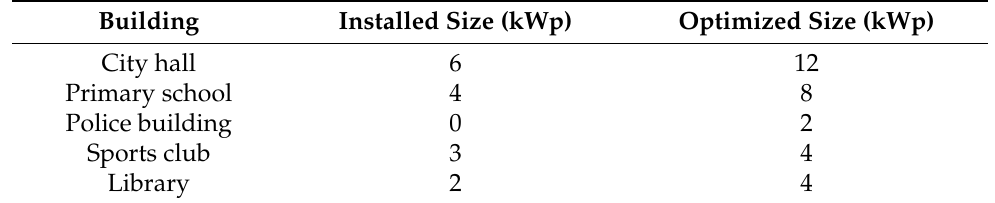
Table 3. Current and optimized size of PV generation per each building during the whole year.